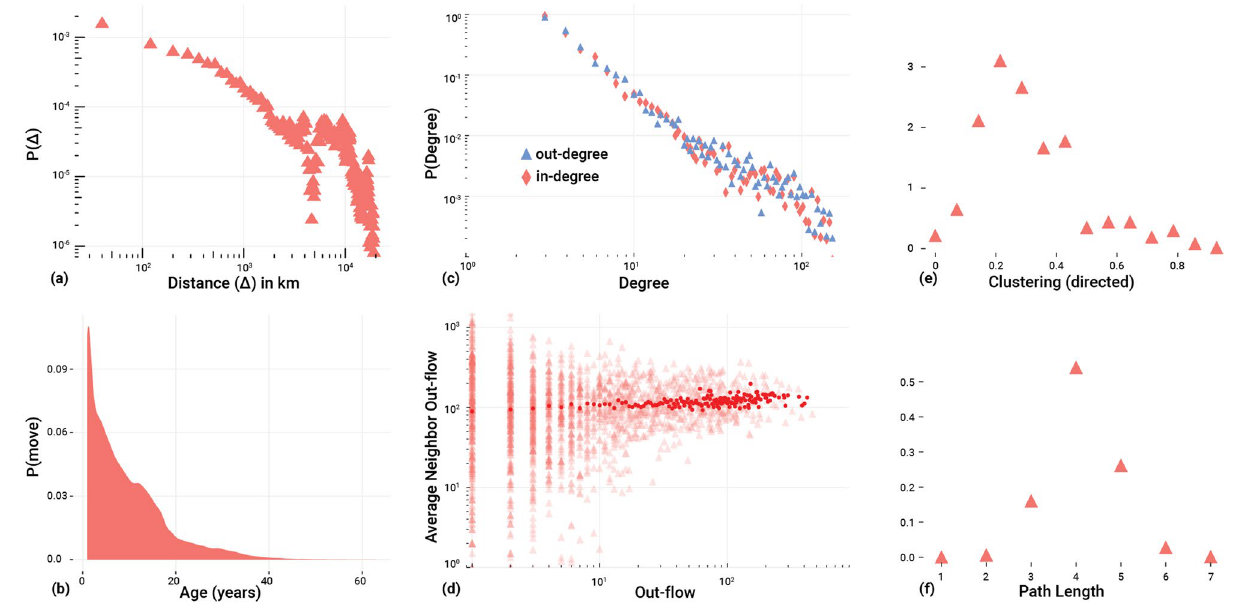
Figure 1. Characterization of the empirical academic mobility. At the individual level, we have the distribution of relocation distances of scientists ( a ) and the distribution of moves dependent on the (academic) age of scientists ( b ). At the global level, we reconstruct the mobility network for which we plot the distribution of degrees ( c ), path lengths ( f ), and local clustering coefficients ( e ). In ( d ), we plot the average out-flow of neighbors of a city a function of its out-flow: each red triangles represents a city, while the red points represent averages taken over cities with the same out-flow. Note that the plots in ( a , c , d ) are in